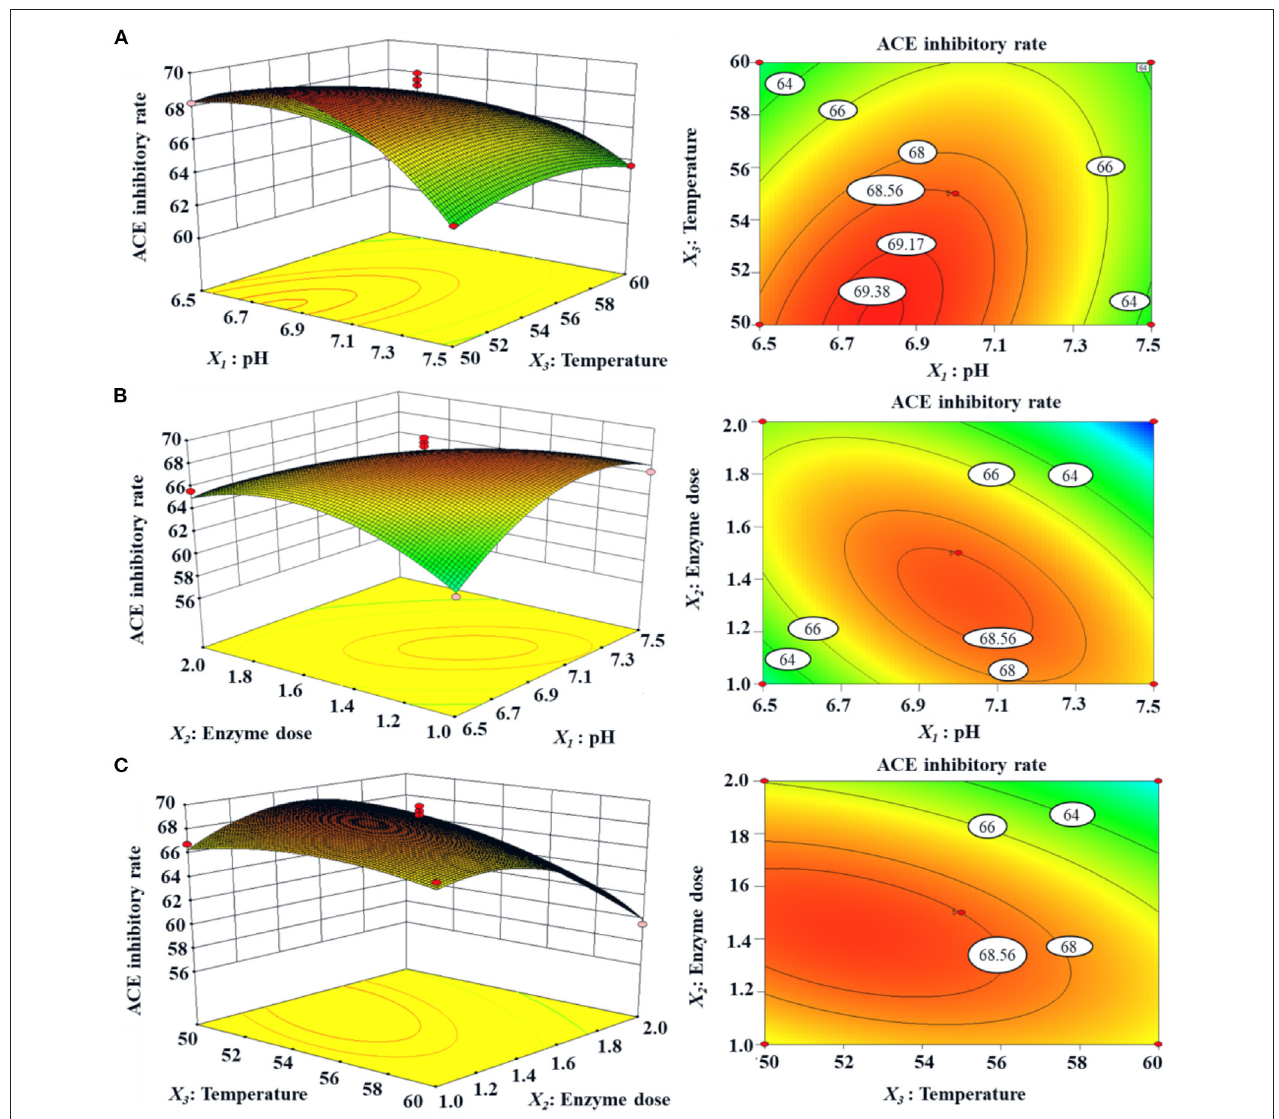
FIGURE 3 | Response surface graph for ACEi rate (%) as a function of (A) temperature and pH, (B) enzyme dose and pH, (C) enzyme dose and temperature during the hydrolysis of skipjack tuna dark muscle with